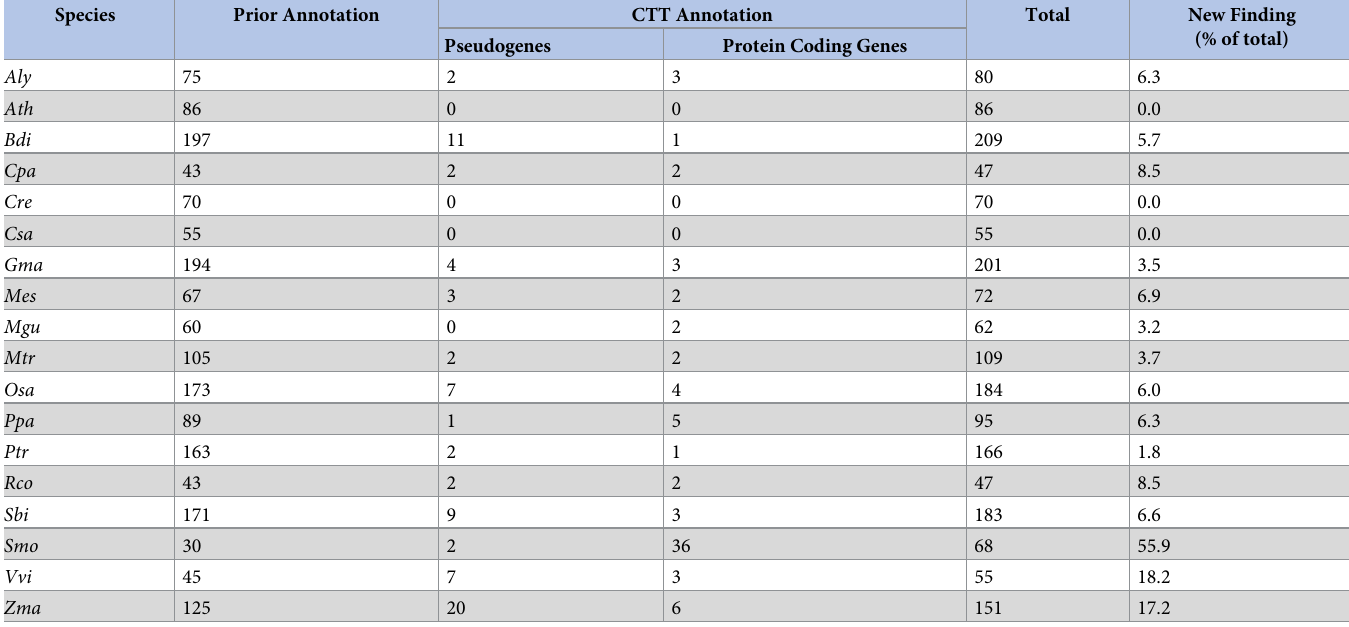
Table 4. CTT annotation of BTB genes in 18 plant